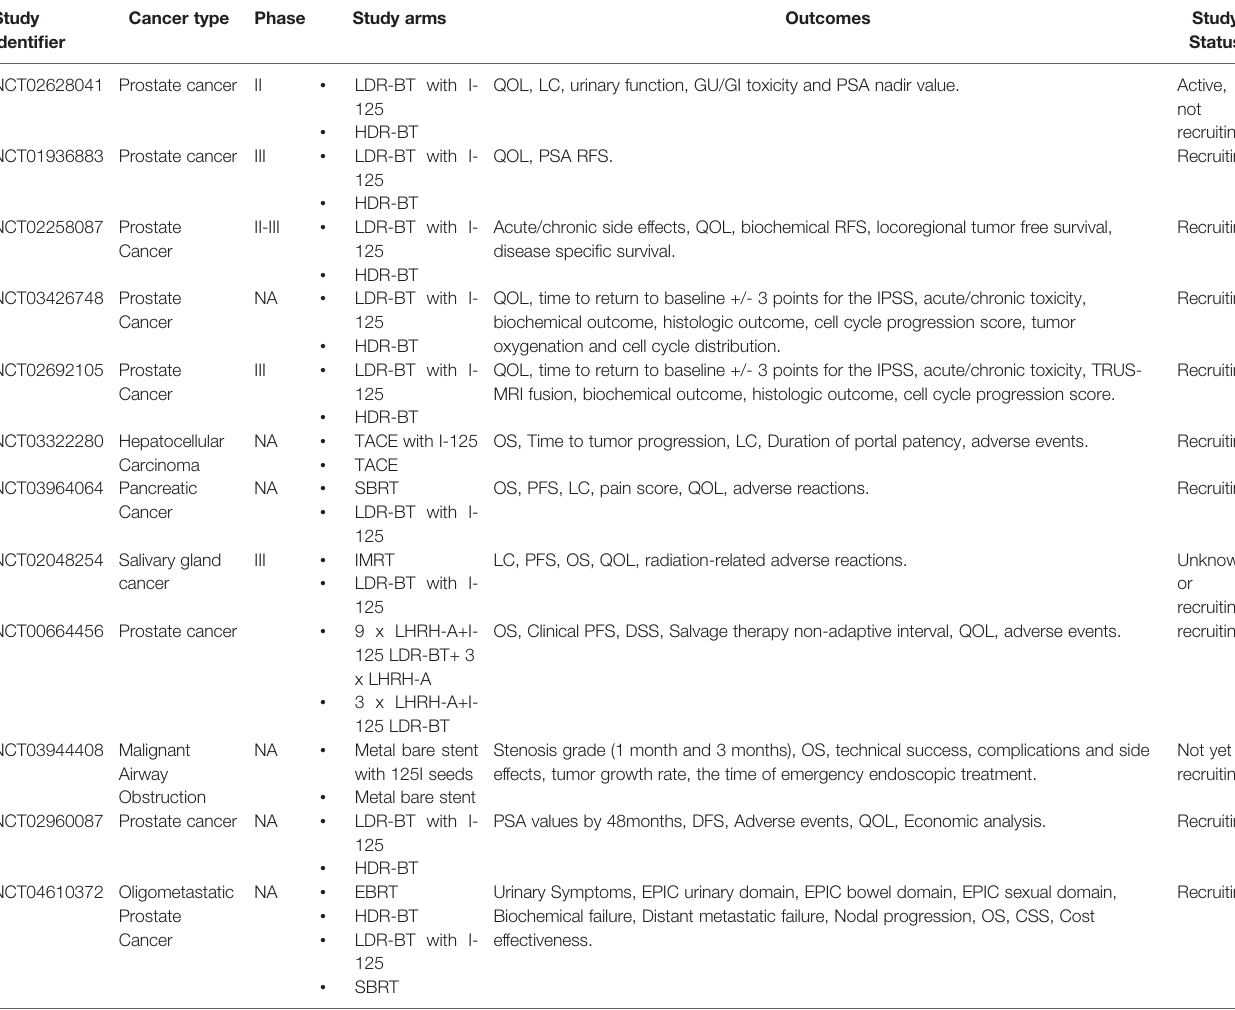
TABLE 5 | Ongoing studies comparing I-125 BT with